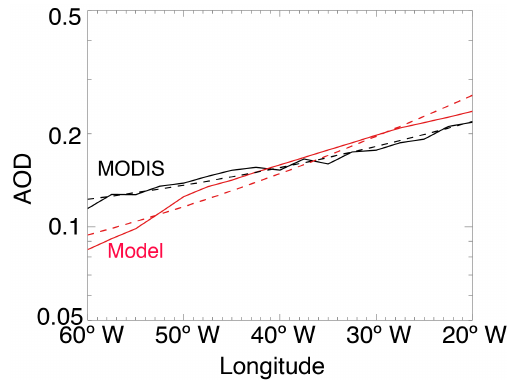
Figure 5. Seasonal AOD at 550nm along transects from 20 to 60 ◦ W from MODIS (black) and model (red), averaged over 5 ◦ S– 25 ◦ N and January–April 2014. The solid lines are averaged AOD and the dashed lines are the logarithmic trend line.